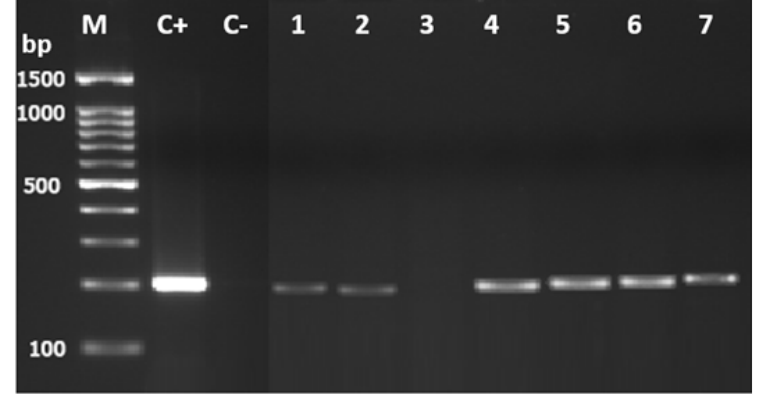
Fig. 2. PCR agarose gel electrophoresis analysis showing the vvhA gene in V. vulnificus by using PCR. Lane M: molecular weight marker (100 bp DNA ladder; Promega); C+, V. vulnificus (positive control); C-, negative control; 1 to 7, representative isolates of V. vulnificus isolated in this study.